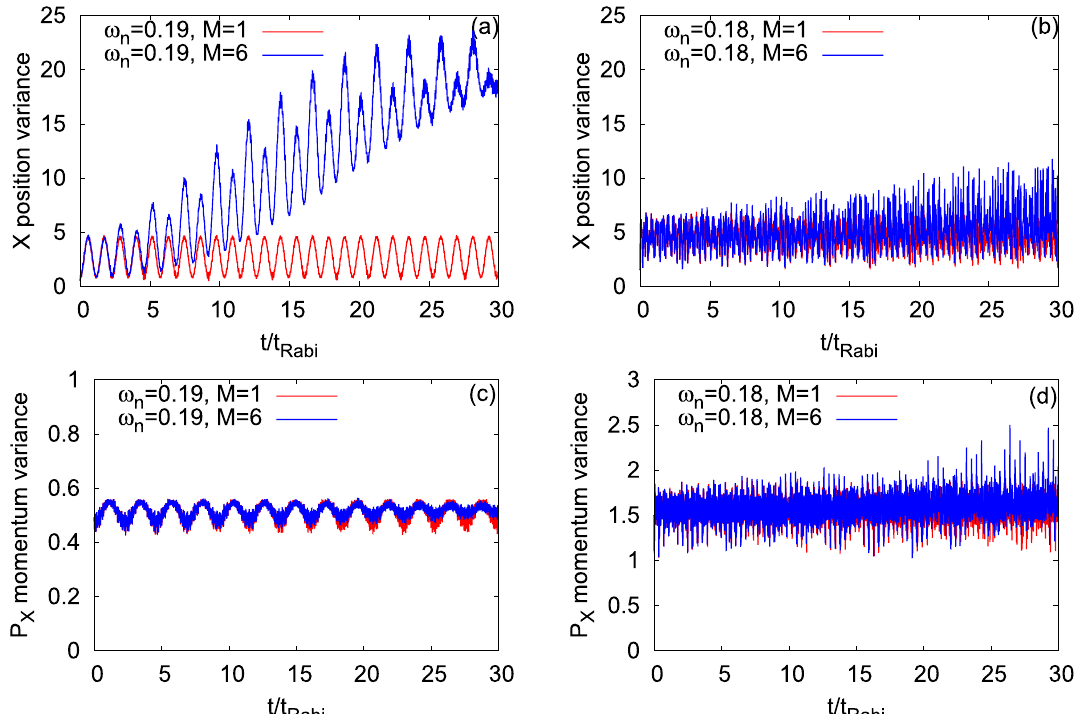
Figure 13. Time-dependent position and momentum variances per particle along the x -direction in a 0.19 ) and (cid:31) X (right column, transversely-asymmetric 2D double-well potential for (cid:31) G (left column, ω n = 0.18 ) under transversal resonant tunneling conditions. The number of bosons is N 10 and the ω n = = 0.01 π . M 1 signifies the mean-field results. The many-body dynamics are interaction parameter � = = 6 time-dependent orbitals. We show here dimensionless quantities. Color codes are computed with M = explained in each becomes gradually slower away from the resonant tunneling. The loss of coherence at the resonant tunneling are 30 t seen to be almost 35% and 5% for (cid:31) G and (cid:31) X , respectively, at the maximum time ( t Rabi ) considered here. = Side by side, the loss of coherence in the system is accompanied by a growing degree of fragmentation, leading to increase of the occupancy of higher natural orbitals. See the supplemental materials for the detailed analysis of the mechanism of fragmentation in transversal resonant tunneling as well as to verification of convergence. To further characterize the many-body correlations at the transversal resonant tunneling condition for (cid:31) G and (cid:31) X , we graphically present the dynamical behavior of the variances of the position and momentum operators along the x - and y -directions, and the angular-momentum operator. Also, the many-body results are compared with the corresponding mean-field results. These physical quantities at other values of ω n , i.e., 0.18 and 0.20 for (cid:31) G and 0.19 and 0.20 for (cid:31) X , along with their convergences are demonstrated in the supplemental materials. Figure 13 displays the dynamics of the many-particle position and momentum variances per particle along 1 1 � 2 ( t ) and � 2 ( t ) , respectively, at the transversal resonant tunneling conditions of (cid:31) G and the x -direction, N N 1 1 ˆ X ˆ P X � 2 ( t ) and � 2 ( t ) for (cid:31) G and (cid:31) X in the symmetric double-well potential are discussed in (cid:31) X . Details of N N ˆ X ˆ P X Fig. S1 of the supplemental materials. The panels show that the fragmentation developed in the system yields the deviation of the many-body results compared to the corresponding mean-field one. This deviation is larger for (cid:31) G in comparison with (cid:31) X , which is consistent with the corresponding survival probability. For (cid:31) G , the 1 1 � 2 ( t ) and � 2 ( t ) almost reach at its equilibrium when the density oscillations many-body dynamics of N N ˆ X ˆ P X collapse. It is found that the frequency of oscillations is practically the same for the mean-field and many-body 1 1 � 2 ( t ) and � 2 ( t ) . As we have seen in the dynamics of the survival probability, the oscillation dynamics of N N ˆ X ˆ P X frequency of both quantities is higher for (cid:31) X compared to (cid:31) G . Moreover, both for (cid:31) G and (cid:31) X , we find that the 1 � 2 ( t ) while they frequency of oscillations of the survival probability is twice the frequency of oscillations of N 1 ˆ X � 2 ( t ) . An interesting many-body feature is observed for (cid:31) G in the time evolution are practically identical for N 1 ˆ P X � 2 ( t ) . Here, we find that there are two types of oscillations taking place, namely, one with high amplitude of N ˆ X and the second with a small amplitude. This type of oscillations may arise due to the transition of bosons from the lower to higher band, which requires a detailed analysis. Many-body linear-response theory 94 , is capable of identifying many-body excitation spectrum of interacting bosons, which goes beyond the scope of the present